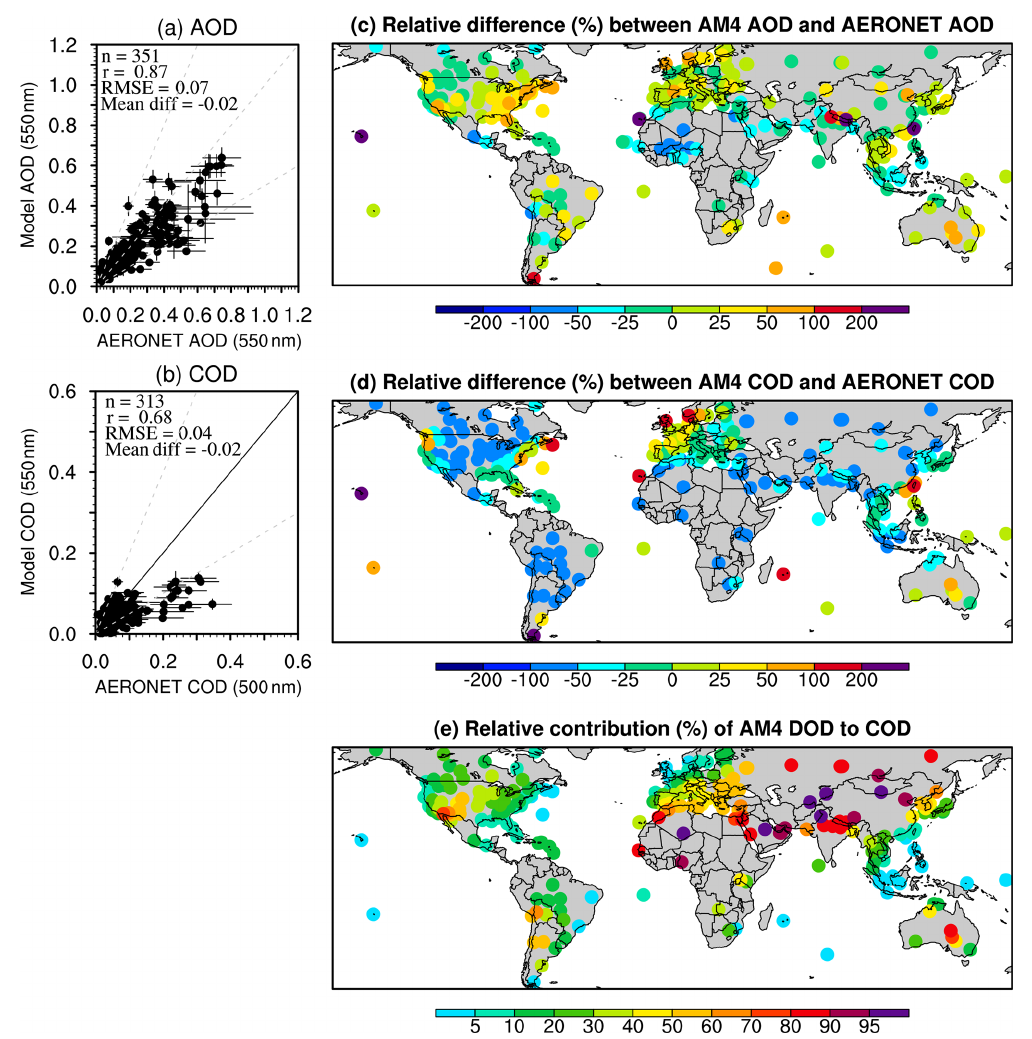
Figure 5. Scatter plot of simulated annual mean (a) AOD and (b) COD in the Control run versus AERONET AOD and COD (a, b) . The relative difference (as a percentage) (c) between modeled AOD and AERONET AOD and (d) between modeled COD and AERONET COD (c–e) . (e) The relative contribution of DOD to COD in the